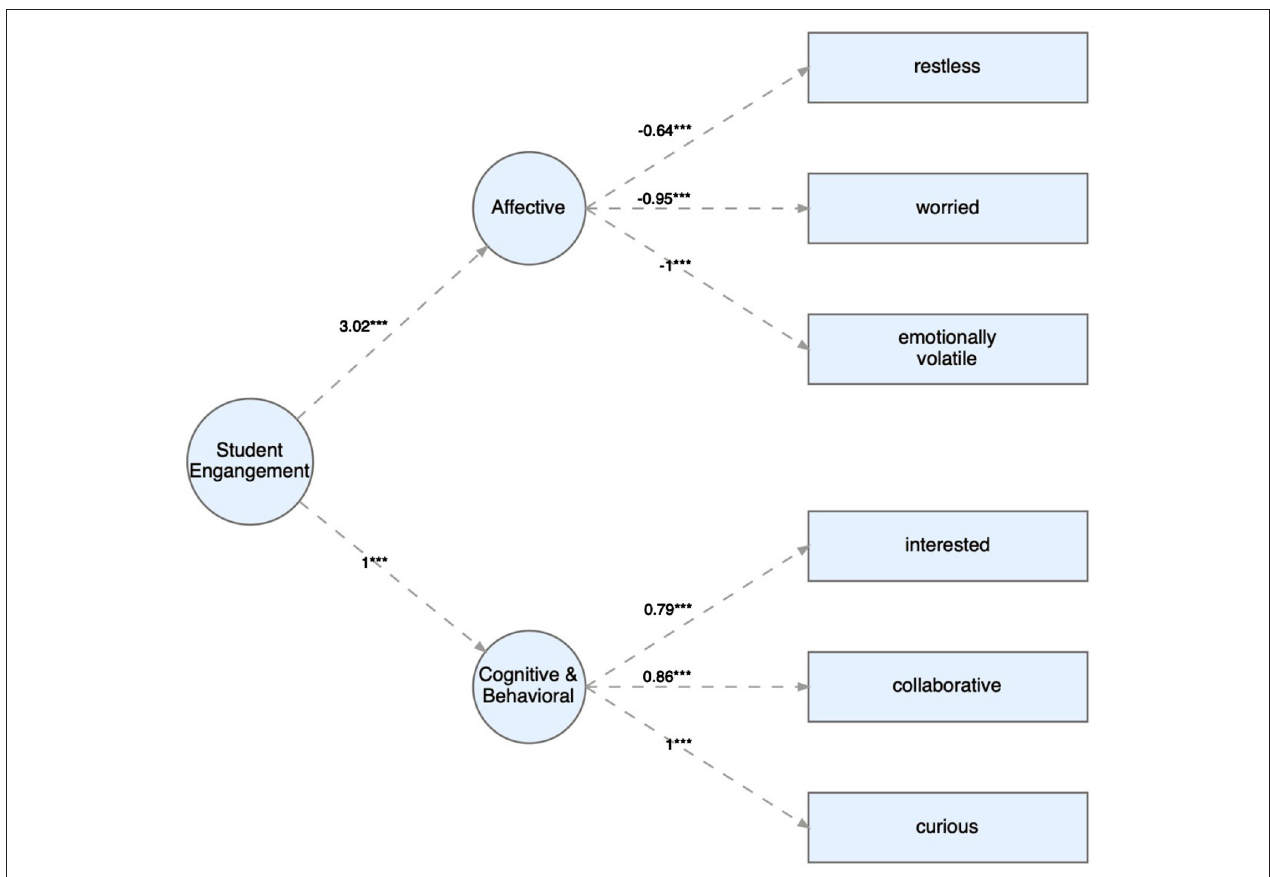
FIGURE 1 | CFA students’ engagement. *** p <